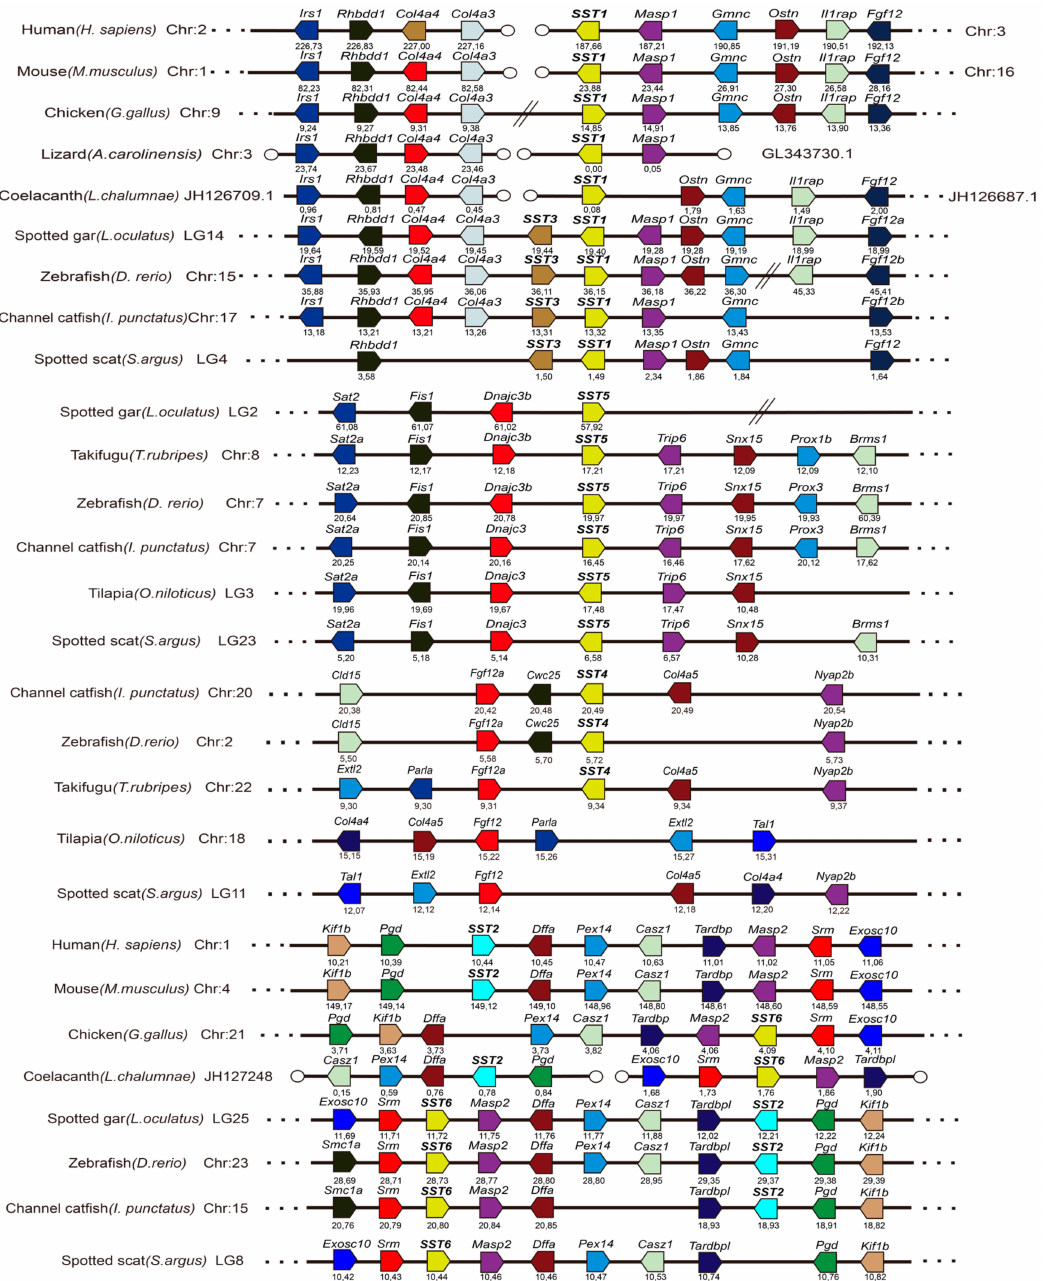
Figure 3. Conserved synteny analysis of SST genes from S. argus using the genomes of 10 selected vertebrate species (human, mouse, chicken, lizard, coelacanth, spotted gar, zebrafish, channel catfish, tilapia, and fugu). Genes are represented by pentagons, and the directions of the reading frames are represented by the direction that the pentagon is pointing. Empty circles indicate the end of sca ff olds. Gene positions (in megabases -Mb) are displayed below each pentagon. The detailed chromosomal positions of the genes used are presented in Table